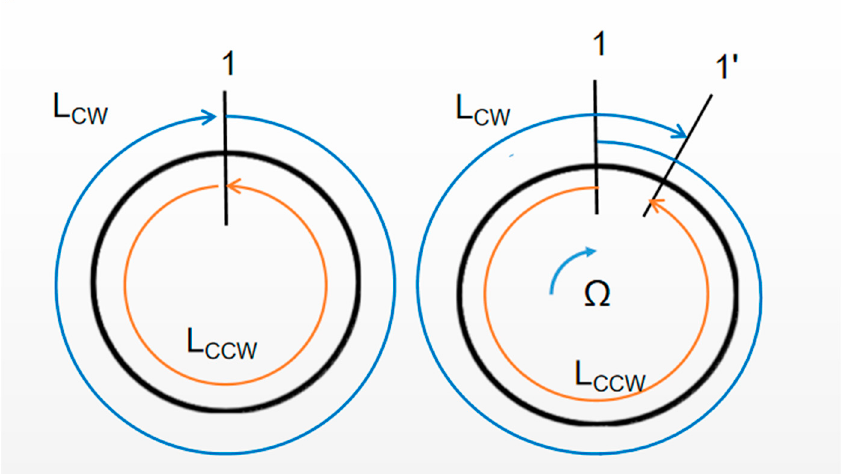
Figure 1. Schematics of the Sagnac effect. The black rings represent the waveguide ring resonators (WRRs). The left panel: the situation of zero rotation rate. The right panel: the WRR under Ω rotation rate. Difference between clockwise (CW) and counterclockwise (CCW) optical paths caused by the Sagnac effect is shown.